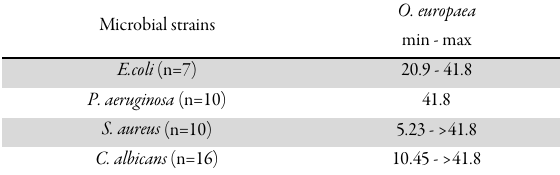
Table 4. The values of MFI for EB stained microbial cells exposed to O. europaea oil at 1/2 × O. europaea